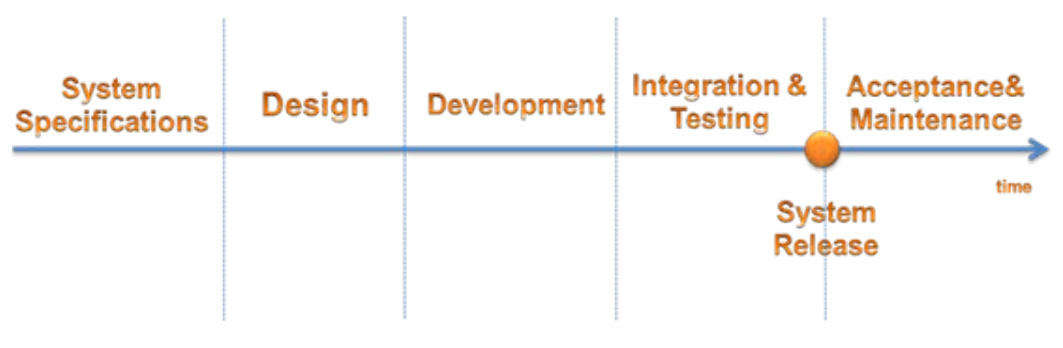
Figure 3. Embedded System Design Life